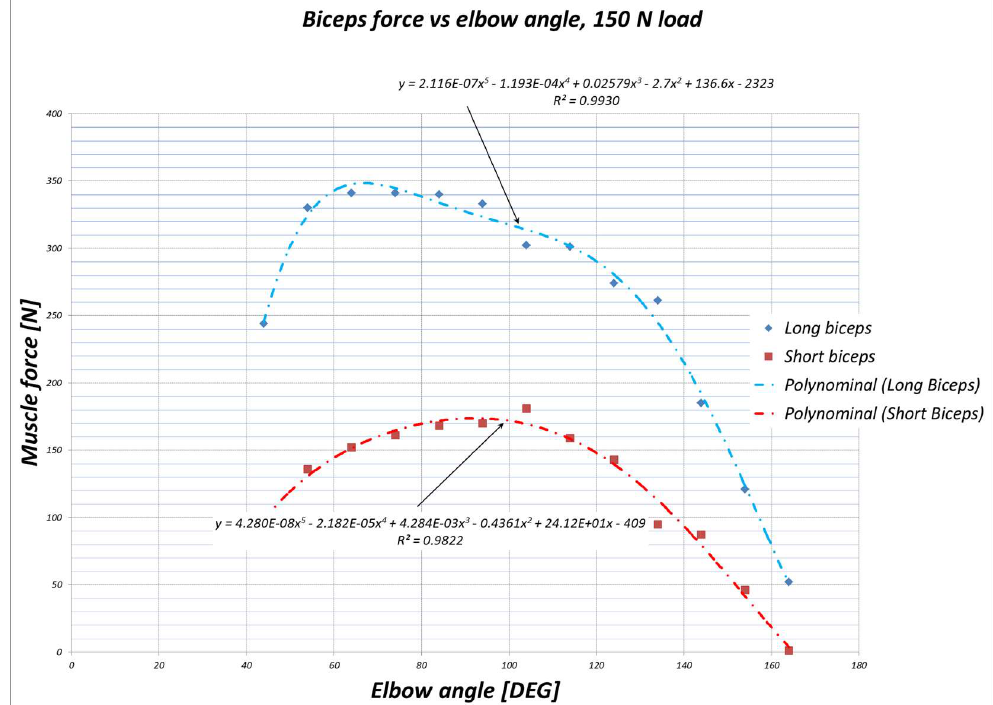
Figure 13. Calculated (dots) and tendency polynomial equation (dash point line) comparison, for biceps forces ( y -axis). Isometric contractions on the elbow at different positions, from 44 to 164 degrees ( x -axis) and 150 N are loaded on the wrist.